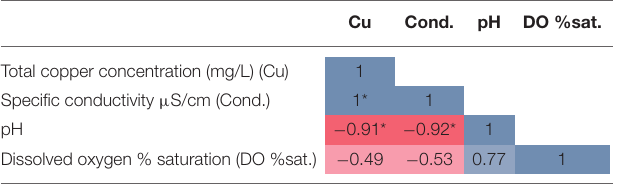
TABLE 2 | Correlations among metadata variables.